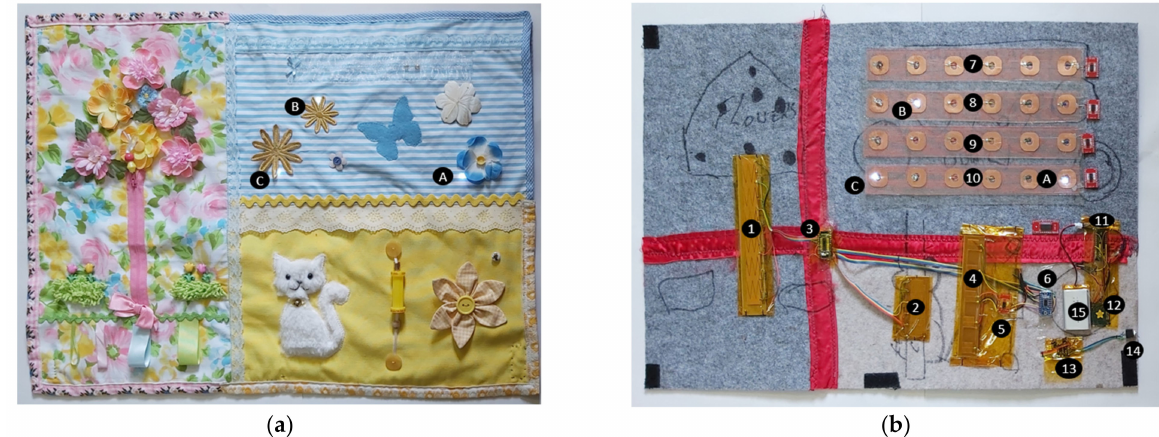
Figure 3. The two layers of the smart textile: ( a ) textile layer with persona metaphors—including cat, tree, sky; ( b ) technological layer where all the components are attached (refer to Table 1 for the list of